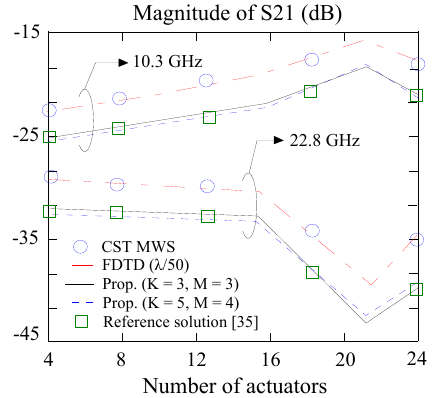
Figure 5: An indicative 2×1 element of the electrically-large 25×1 circularly-polarized wideband patch array. Modeling regions: complex-interface schemes for the corners and the segments, optimized FVTD technique for the patches and the PML, and PSTD algorithm for the rest of the domain.